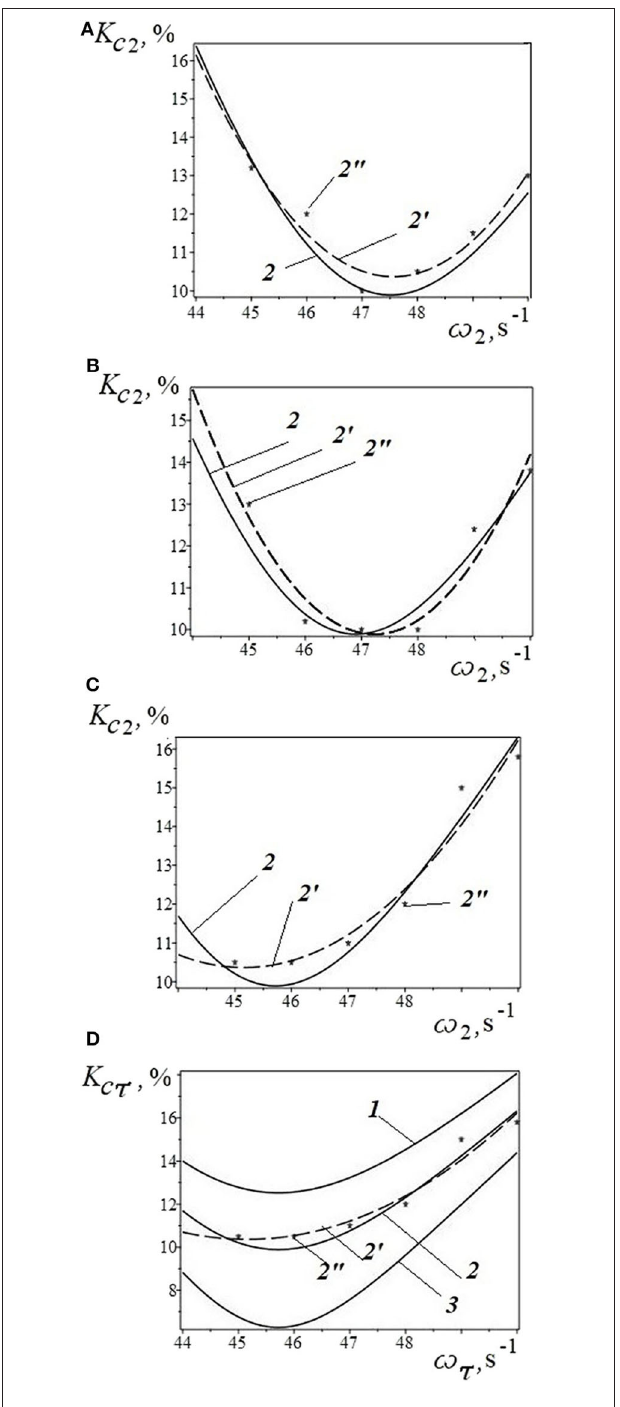
FIGURE 2 | The dependence of the heterogeneity coefficient K C τ ( ω τ ) (%) for a mixture of semolina GOST 7022-97 and natural sand GOST 8736-93 in the = 1 / 10 : (A–C) K C 2 ( ω 2 ) (%) for the / α 2 , n ratio of their volume fractions α 1 , n ϑ ϑ intermediate mixing stage ( τ = ϑ = 2 ); (D) for three stages of mixing ( τ = 1 , 2 , 3 ), (A) 1 2 = 1.45 ; (B) 1 2 = 1.5 ; (C,D) 1 2 = 1 τ = 1.6 ; 1 — τ = 1 ; 2 — τ = 2 ; 3 — τ = 3 ; 2 —theory, 2 ′ —regression curves (A) : K C 2 ( ω 2 ) = 1040 − 43.3 ω 2 + 0.46 ω 22 ; (B) : K C2 ( ω 2 ) = 1261 − 53 ω 2 + 0.56 ω 22 ; (C,D) : K C 2 ( ω 2 ) = 520 − 22 .5 ω 2 + 0.25 ω 22 , 2 ′′ are the